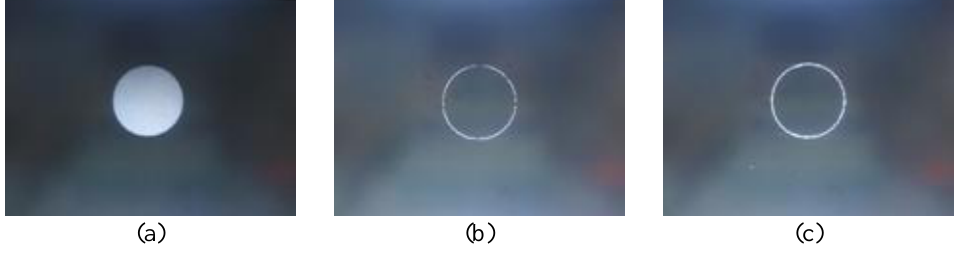
Figure 14. ( a ) Circle image; ( b ) Result of [12]; ( c ) Result of proposed canny.